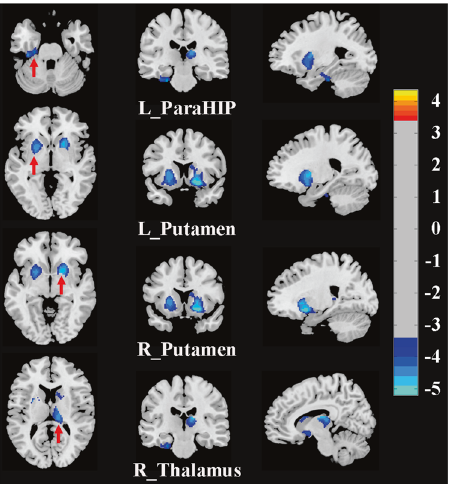
Fig. 1 Brain regions with signi fi cant differences in GMV between SAD patients and HCs (corrected with Gaussian random fi eld theory with a signi fi cance threshold of a voxel-wise value of P < 0.001 and cluster probability of P < 0.05). Warmer colors (positive values) represent increased GMV, while cooler colors (negative values) represent decreased GMV in SAD patients compared to HCs.